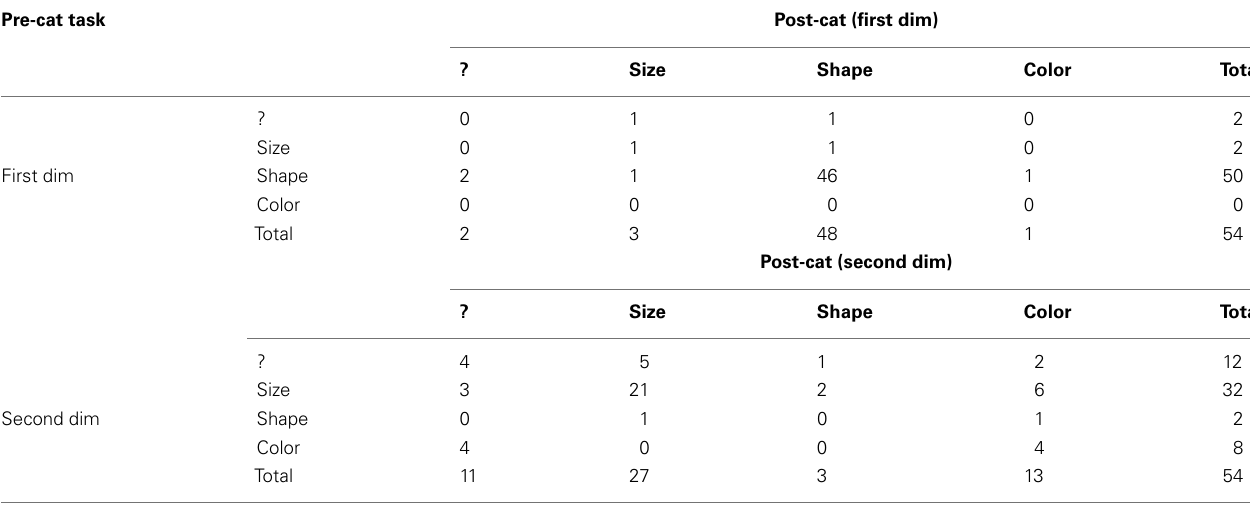
Table 1 | Crosstab showing how many times each of the dimensions (Size, Shape, or Color) could be mapped to the MDS results, during the pre- and post-categorization